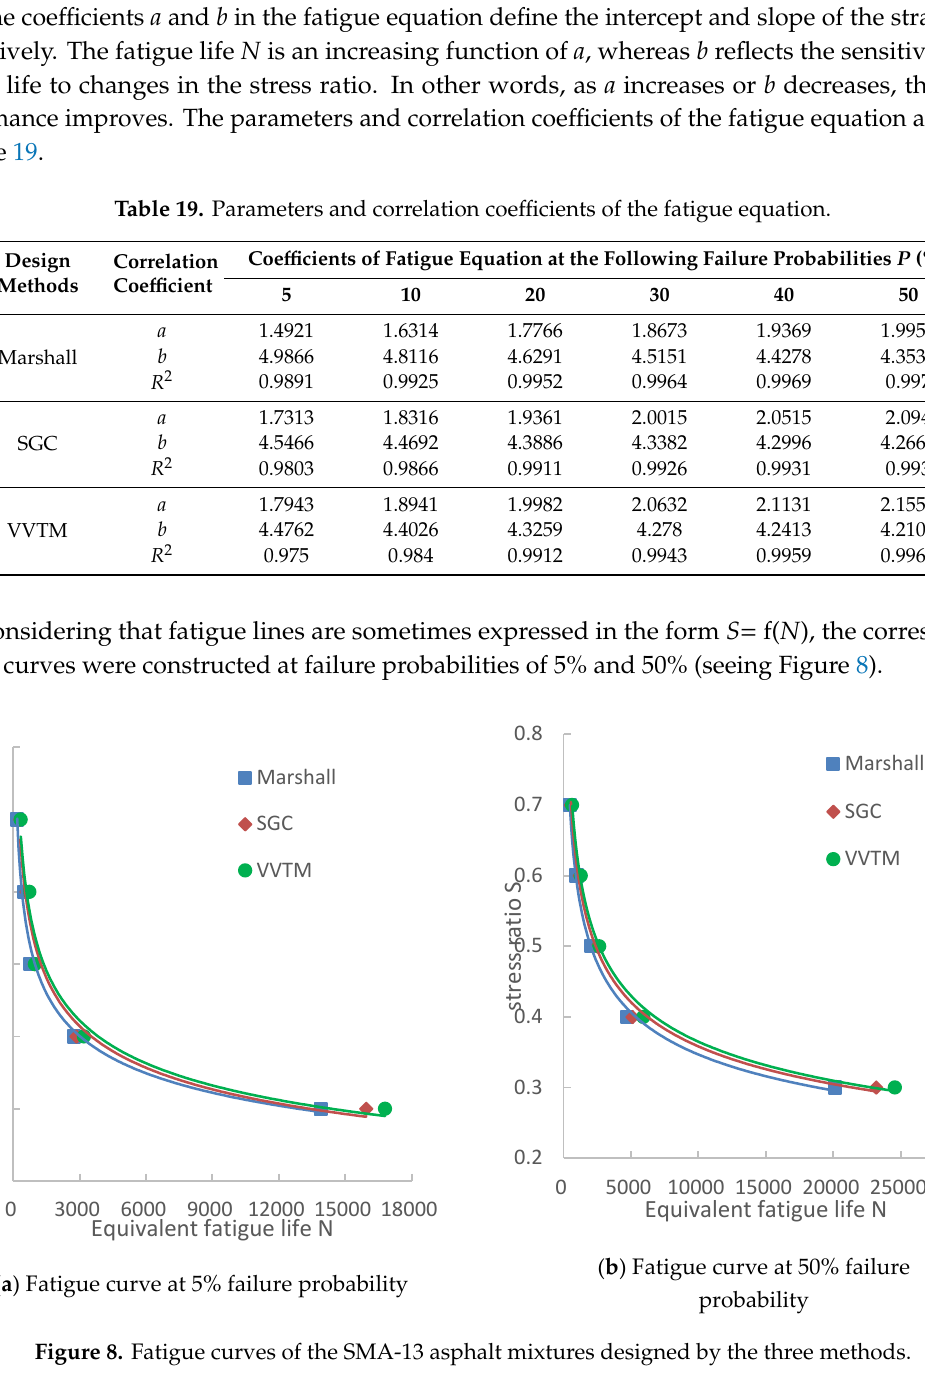
Table 19. Parameters and correlation coefficients of the fatigue equation.